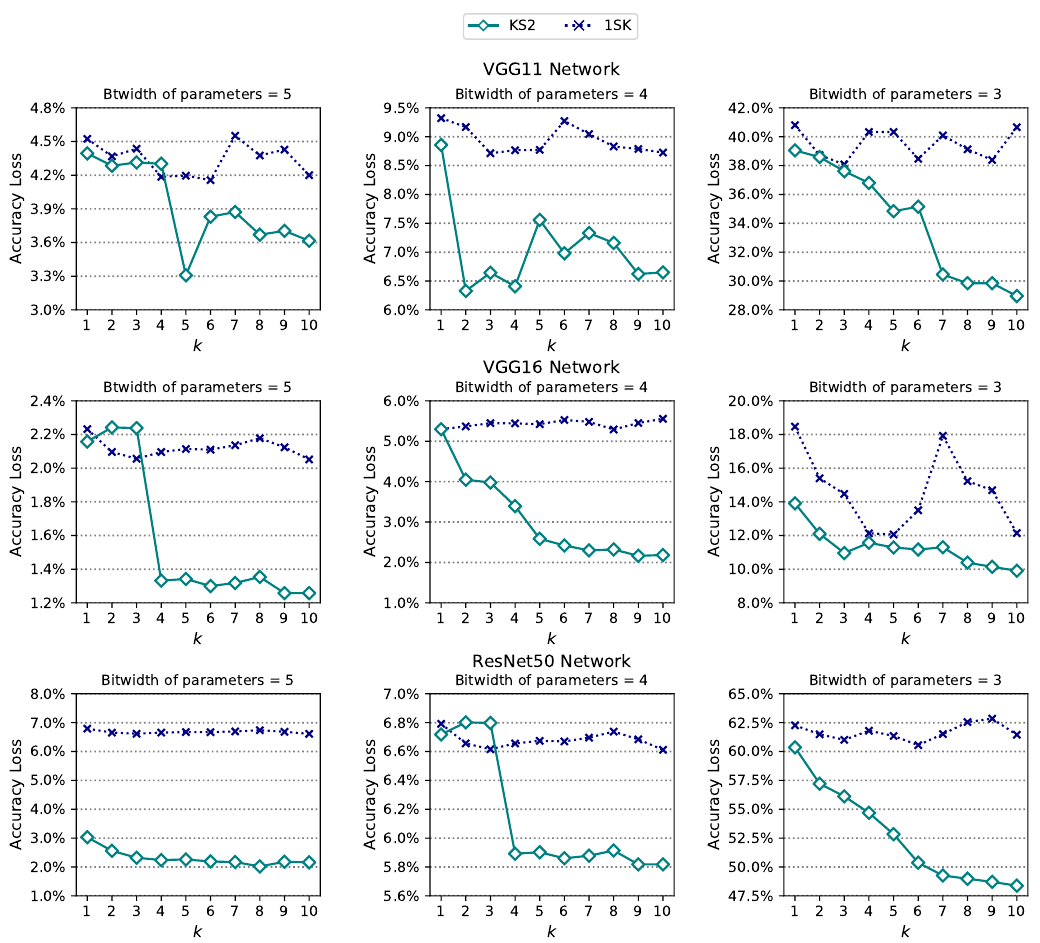
Figure 6. Among the two local decomposition methods, KS2 performs best overall.